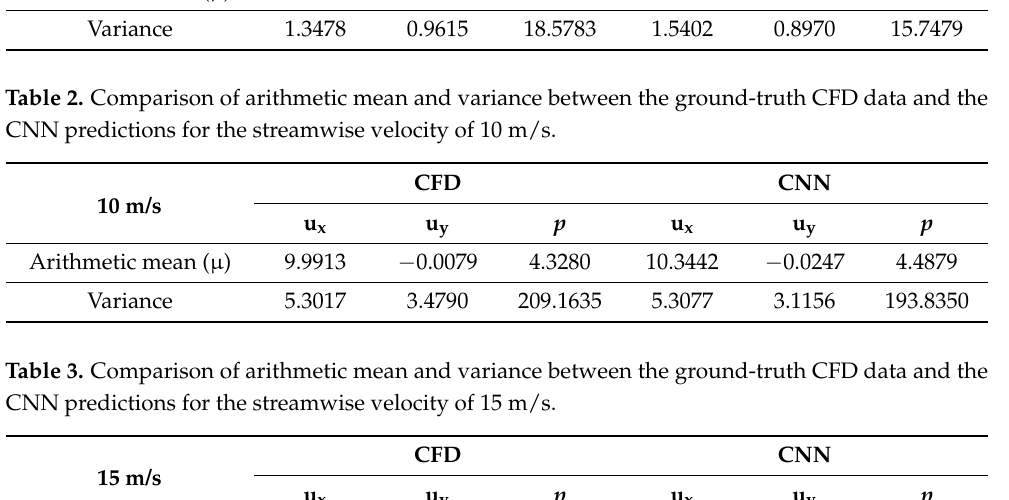
Table 1. Comparison of arithmetic mean and variance between the ground-truth CFD data and the CNN predictions for the streamwise velocity of 5 m/s.